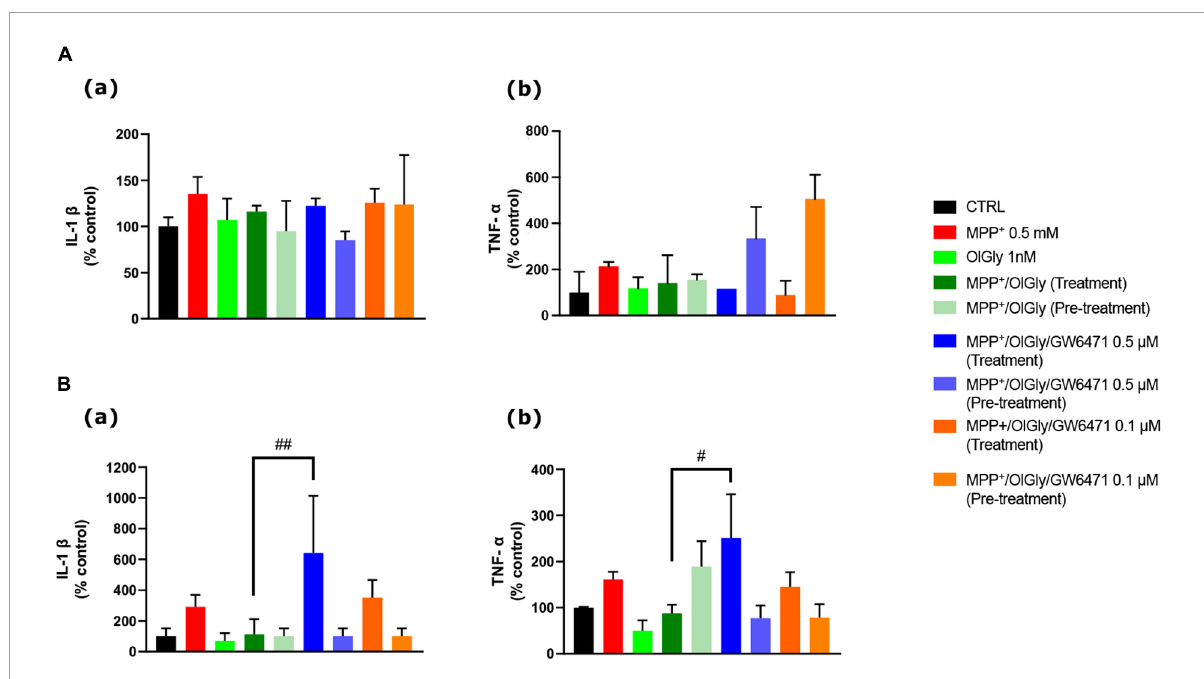
FIGURE8 Effect of MPP + on (a) Interleukin-1 β (IL-1 β ) and (b) tumor necrosis factor- α (TNF- α ) protein expression levels in (A) not differentiated and (B) differentiated SH-SY5Y cells measured by ELISA. Histograms represent the percentage, with respect to control cells (CTRL, 100%), of viable cells after the exposure to MPP + (0.5 mM), OlGly (1 nM), and GW 6471 (0.5 and 0.1 µ M) in both simultaneous treatment and pre-treatment experiments. Data are represented as mean ± SEM. ∗ Indicates values statistically significant vs. MPP + . Student’s t -test has been used for statistical analysis ( N = 6). ## Indicates values statistically significant with p < 0.01; # Indicates values statistically significant with p <